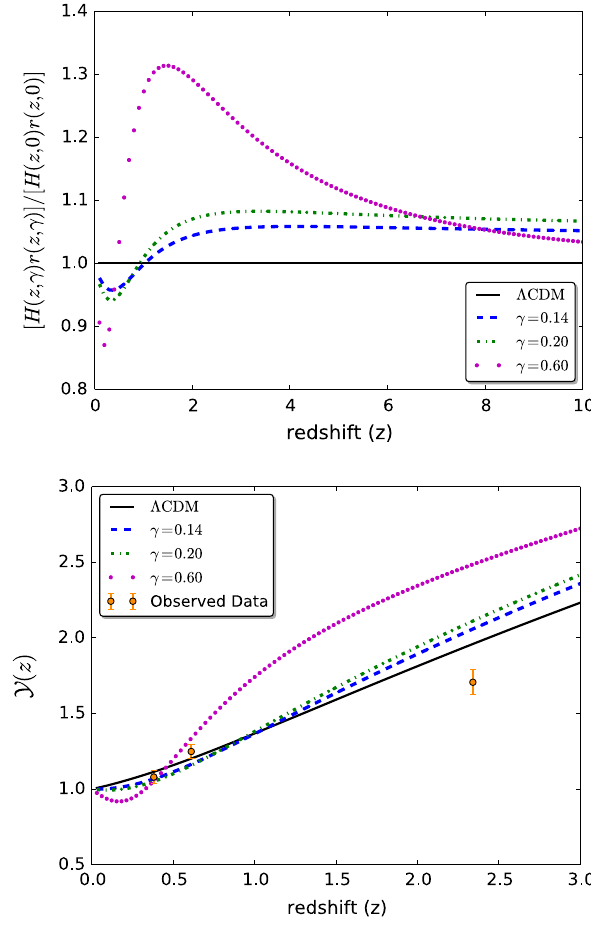
Fig. 6 Upper panel Alcock–Paczynski test compares (cid:20) z /(cid:20)θ normal- ized to the case of Λ CDM model (γ = 0 ) as a function of the redshift for different viscosity coefficients. Lower panel Y ( z ;{ Θ p } ) for viscous dark energy and Λ CDM models. In addition three observed points are illustrated for better comparison. The other free parameters have been fixed by SNIa observational constraint. The Λ CDM best fit is given by Planck